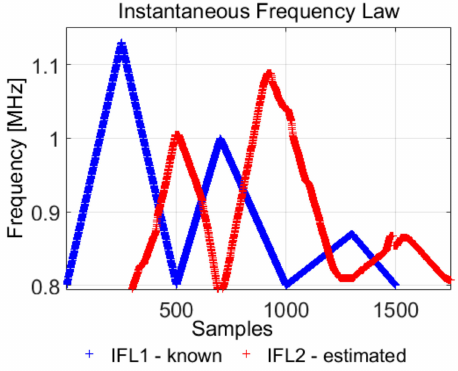
Figure 17. The spectrogram based estimated IF law of the signal s IFL 12 (dashed black) versus the ideal IF laws: IFL 1 (blue) and IFL 2 (red).